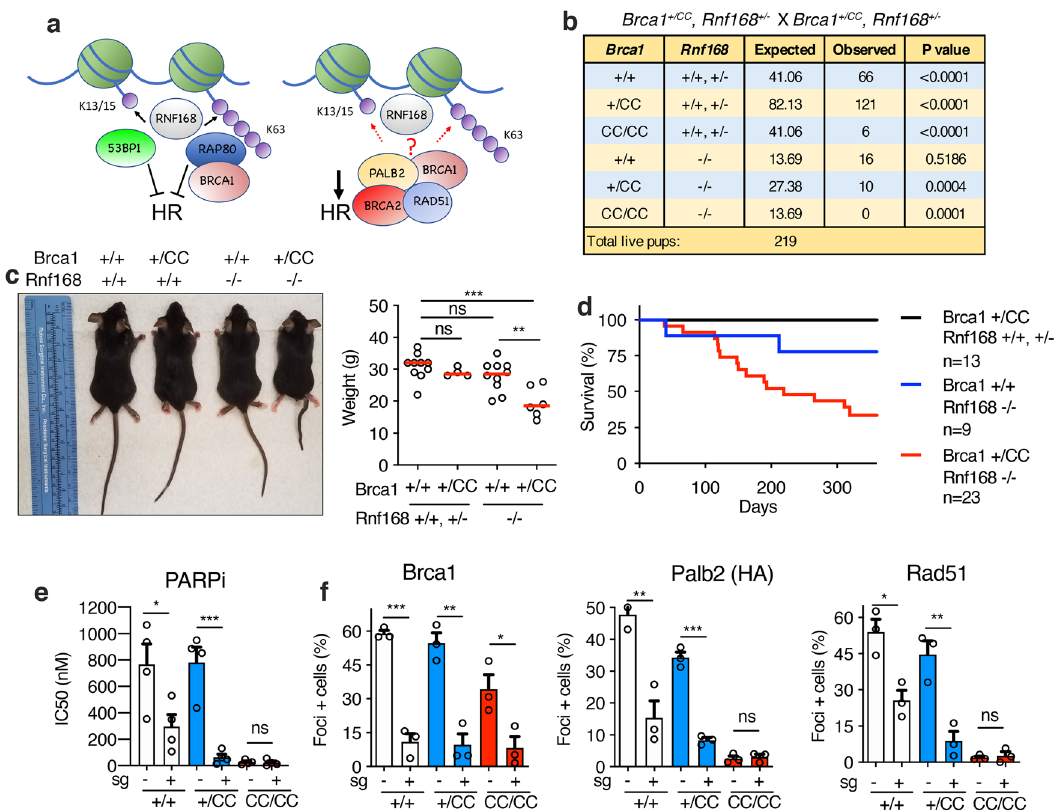
Fig. 1 Rnf168 and Brca1 mutations block development and Brca1-P localization. a Cartoon showing RNF168-mediated and H2A-associated ubiquitin modi fi cations, as well as the in fl uence of 53BP1, BRCA1-A (ABRAXAS-RAP80) and -P (PALB2-BRCA2-RAD51) complexes on HR. b Brca1 + /CC , Rnf168 + / − mice were intercrossed and the numbers of expected and observed live births are shown. P values are obtained from two-sided chi-square goodness of fi t tests for the binomial of each genotype. c Left; representative photograph. Right; weights of individual 4 – 6-month-old mice with the indicated genotypes, red line; median, Brca1 + / + , Rnf168 + / + , + / − ( n = 10); Brca1 + /CC , Rnf168 + / + , + / − ( n = 4); Brca1 + / + , Rnf168 − / − ( n = 10); Brca1 + /CC , Rnf168 − / − ( n = 6) mice. d Kaplan – Meier survival analysis of mice born with the indicated genotypes. e Brca1 + / + , Brca1 + /CC , and Brca1 CC/CC MEFs treated with GFP ( − ) or Rnf168 ( + ) targeting sgRNA were subsequently incubated with increasing concentrations of the PARPi rucaparib and colony formation assessed. Mean and S.E.M. rucaparib IC50 values are shown for n = 4 biological replicates. f Cells from ( e ) were subject to 10 Gy γ -irradiation (IR) and foci formation measured by immuno fl uorescence. Endogenous Brca1 and Rad51 foci, and ectopic HA-PALB2 foci formation was assessed using cell lines expressing HA-PALB2. Foci positive cells were determined to be ≥ 10 Brca1 and Palb2 foci/nuclei, or ≥ 5 Rad51 foci/nuclei. The mean and S.E.M. percentage foci positive cells are shown for n = 3 biological replicates. See Supplementary Fig. 2a for representative images of cells. *** p < 0.001, ** p < 0.01, * p < 0.05, ns not signi fi cant (unpaired, two-tailed t